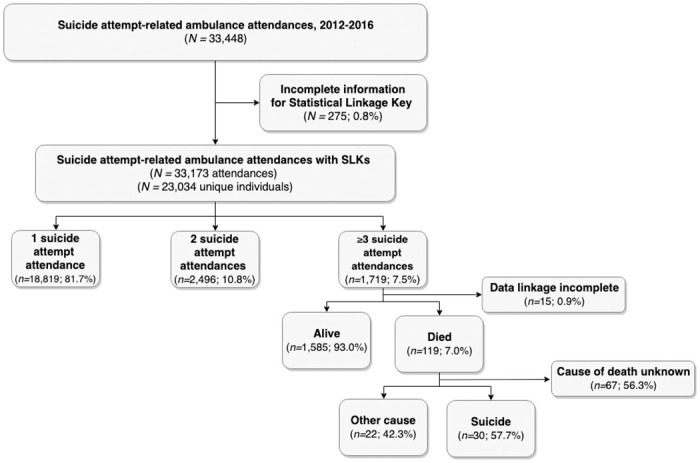
Study flow diagram.